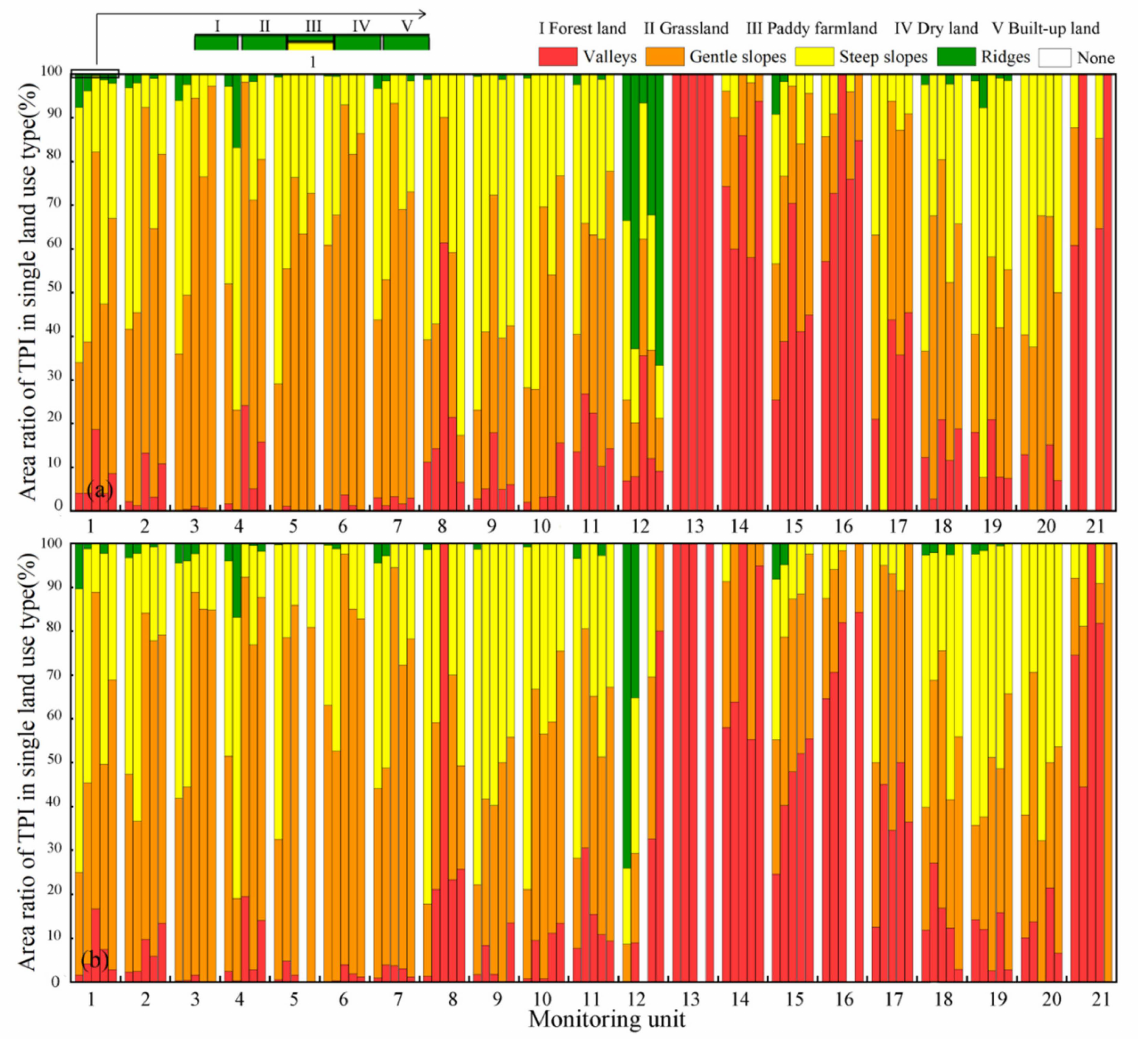
Figure 12. TPI compositions of land use types in the monitoring units: ( a ) 2013 and ( b )